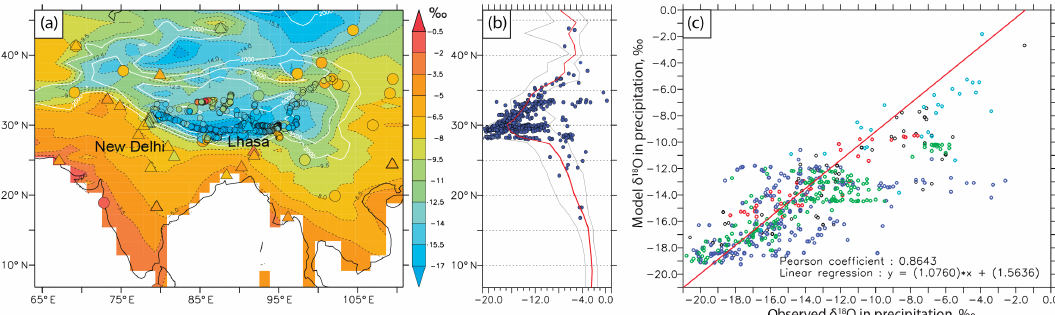
Figure 8. (a) Annual mean δ 18 O in precipitation simulated by LMDZ-iso for MOD case. Triangles show δ 18 O in precipitation from GNIP stations, big circles – δ 18 O in precipitation from Caves et al. (2015) compilation (annual mean and JJA values respectively), small circles represent δ 18 O in streams, lakes and springs compiled from Quade et al. (2011), Bershaw et al. (2012), Hren et al. (2009). (b) S-N profiles of model simulated δ 18 O for the MOD case. Blue points correspond to the same measured data as on (a) . The δ 18 O profile is averaged between 75 and 105 ◦ E. Grey lines show minimum and maximum values for the selected range of longitudes. (c) Observed vs. modelled δ 18 O in precipitation. The colour of circles corresponds to the data set: red – Bershaw et al. (2012), blue – Quade et al. (2011), green – Hren et al. (2009), black – Caves et al. (2015); light blue shows mean annual data from GNIP stations. Red line shows a linear regression.